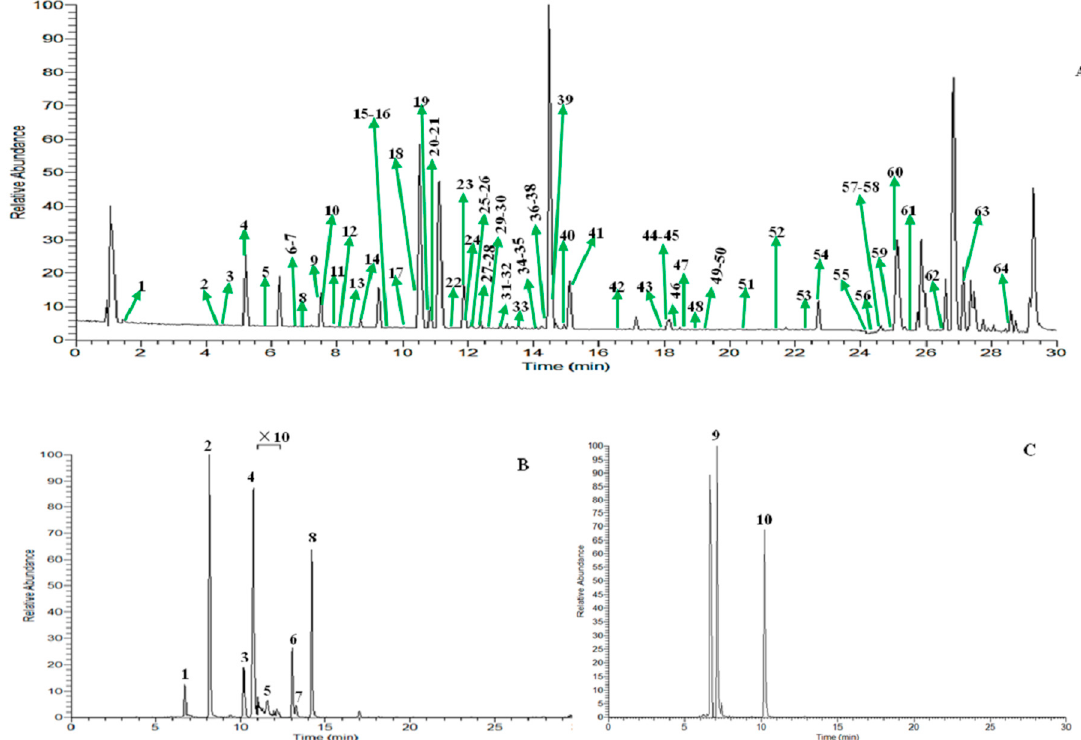
Figure 1. ( A ) Base peak chromatogram of Menthae Haplocalycis herba in positive ion mode; ( B ) base peak chromatogram of mixed reference solution of Menthae Haplocalycis herba. ( 1 . Bohecineole A, 2 . Luteolin-7- O -glucoside, 3 . Diosmin, 4 . Hesperidin, 5 . Rosmarinic acid, 6 . Lithospermic Acid, 7 . Salvianolic acid B, 8 . Buddleoside); ( C ) base peak chromatogram of mixed reference solution of Menthae Haplocalycis herba. ( 9 . (1 R ,2 R ,4 S )- trans -1,8-cineole-2- O - β - D -glucopyranoside, 10 . Naringin). “ × 10” magnified ten-fold